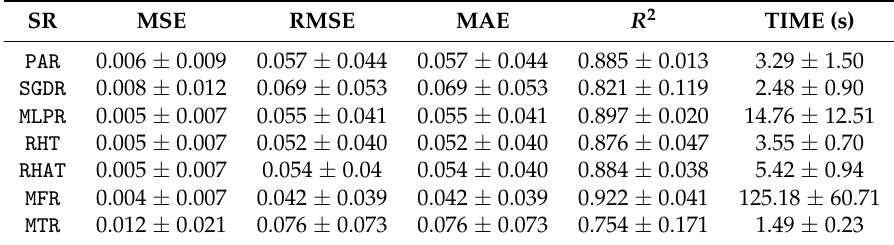
Table 4. Results of the experiment 2: no variable selection with a 5% of preparatory instances. Note that RMSE = MAE because all differences are